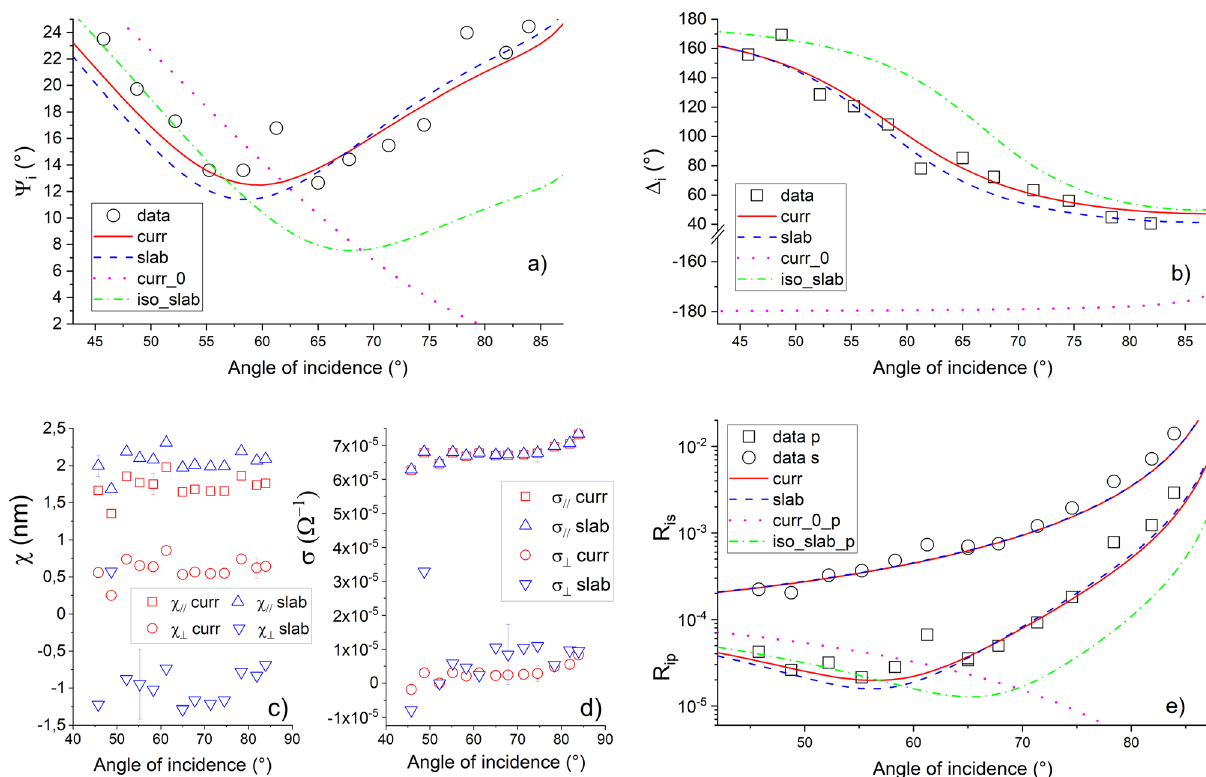
Fig. 2 Experimental results for monolayer graphene immersed in polydimethylsiloxane. Black dots: experimental data, colored dots: extracted optical constants, lines: theoretical fi ts for the four theoretical models considered in this paper. a , b Ellipsometric parameters Ψ i and Δ i . Neither the iso_slab model nor the curr_0 model fi t the data, using as optical constants those extracted from the Ψ s and Δ s . c , d Optical constants determined with slab and the curr model. They predict similar χ ∥ and σ ∥ , but negative and positive χ ⊥ respectively, and σ ⊥ compatible with 0 Ω − 1 . The error bars reported are the standard deviation of these values (see Table 1). e Re fl ectivities for s and p polarized light. Experimental data show a pseudo Brewster angle for R ip . The iso_slab model fails to predict its position by almost 10°. The curr_0 model does not predict it at all. All models fi t R is reasonably well (for clarity we show only the curr model and the slab